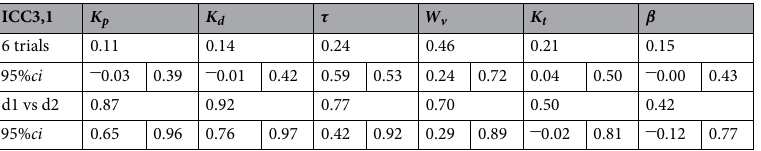
Table 1. Intraclass correlation point estimates (ICC3,1) for the independent channel model parameter estimates. Top row: each of the six short-PRTS recordings of each of the 14 subjects was taken as one measurement. Bottom row: cycles of the three measurements within 1 day were pooled and ICC values calculated for day1 and day2